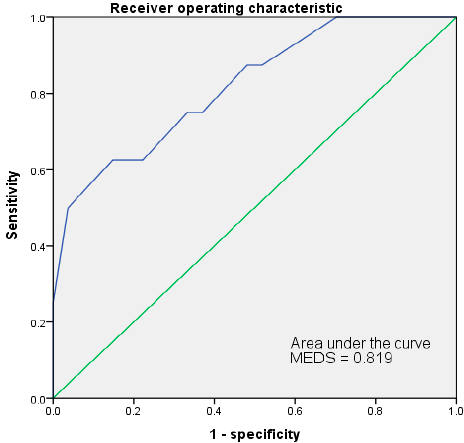
Figure 1. The AUC of ROC for MEDS indicated 0.819 at 12 of the cut-off point to predict the mortality risks of patients with EC. AUC = area under the curve; ROC = receiver operating characteristic curve.